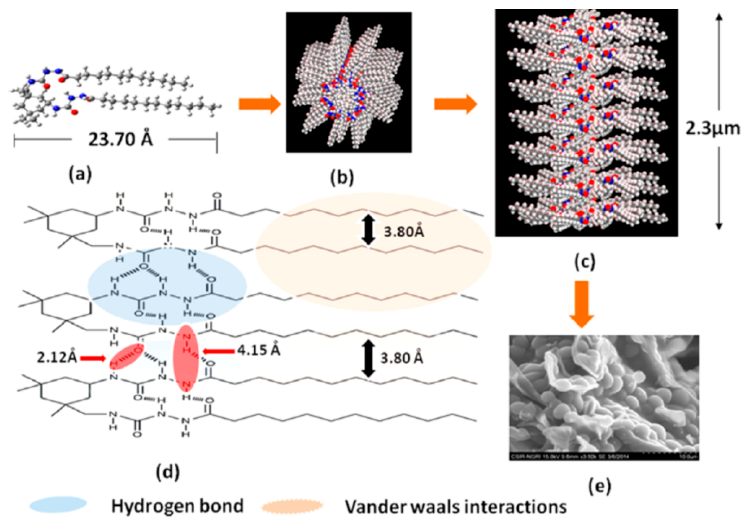
Figure 15. Schematic representation of the C 12 gelator showing the ( a ) molecular length, ( b ) model of the molecular aggregate, ( c ) model of the probable mode of packing within the gel, ( d ) cross section and ( e ) xerogel SEM image. Reprinted with permission from ACS [45].